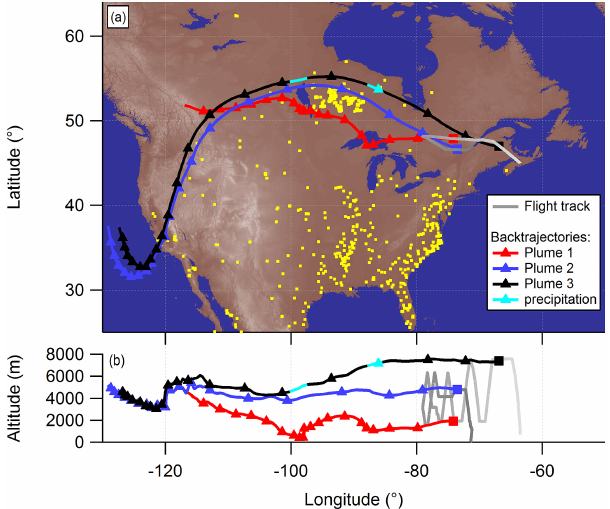
Figure 1. Five-day HYSPLIT back trajectories, starting at the time and location sampled (the square markers) and with triangular markers every 6h. Parts (a) and (b) show the horizontal and ver- tical tracks respectively. The aqua-coloured parts of the trajectories are regions with HYSPLIT precipitation, and the yellow dots show MODIS fire data between 18 and 20 July 2011. The grey line shows the flight track, starting from light grey and ending in dark